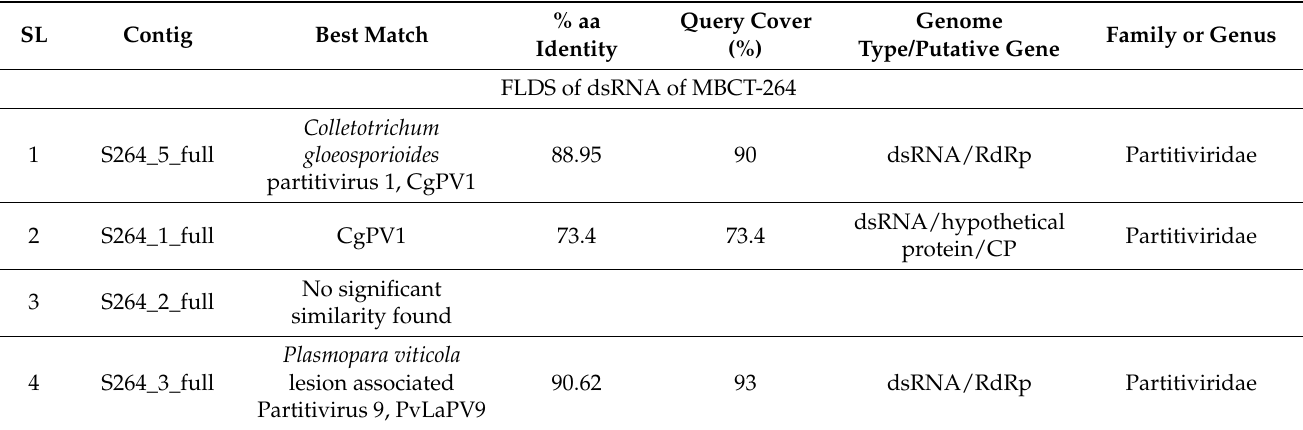
Table 2. Assembled sequences with best similarity in BLASTx to those of previously described